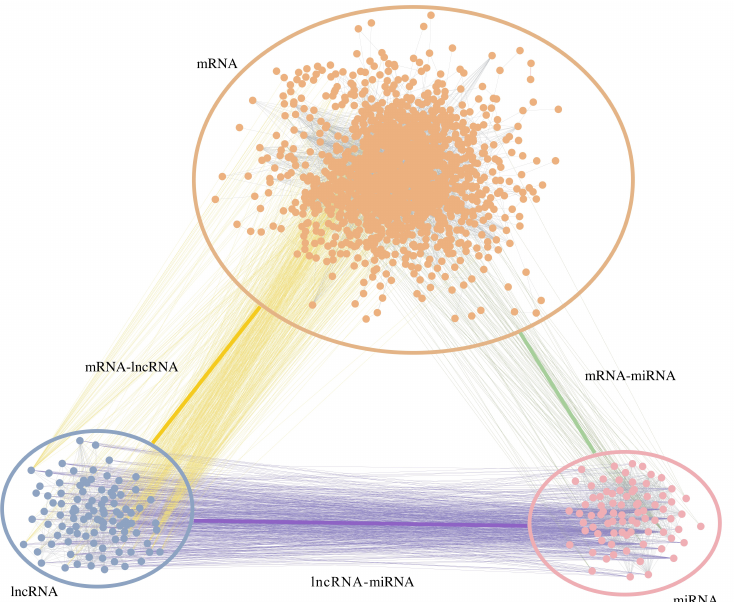
Figure 2. The heterogeneous network of RNA interactions. Orange vertices are mRNAs, pink vertices are miRNAs, and blue vertices are lncRNAs. The grey edges represent the connection within the same kind of RNAs, the yellow edges represent the relationship between mRNA and lncRNA, the green edges represent the relationship between mRNA and miRNA, and the purple edges represent the relationship between miRNA and